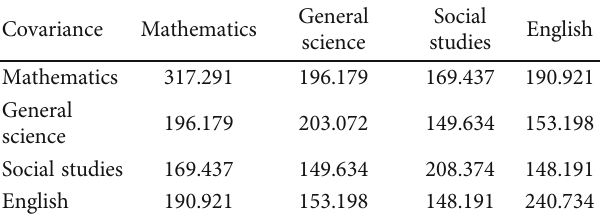
Table 5: The covariance for total boy students.